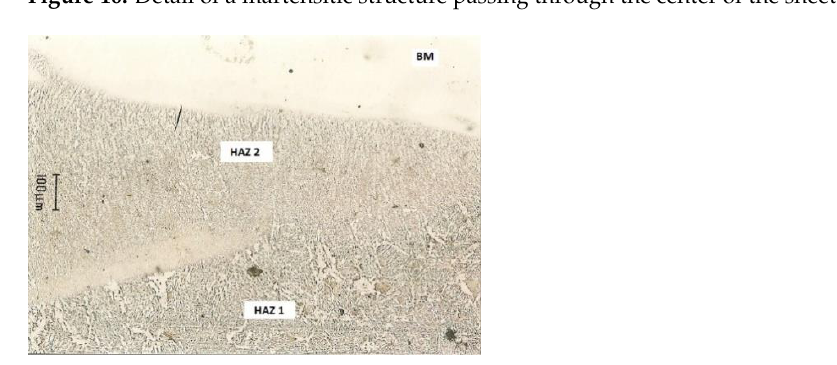
Figure 17. Microstructure of the transition of weld metal to the base material. (HAZ — heat-affected zone).